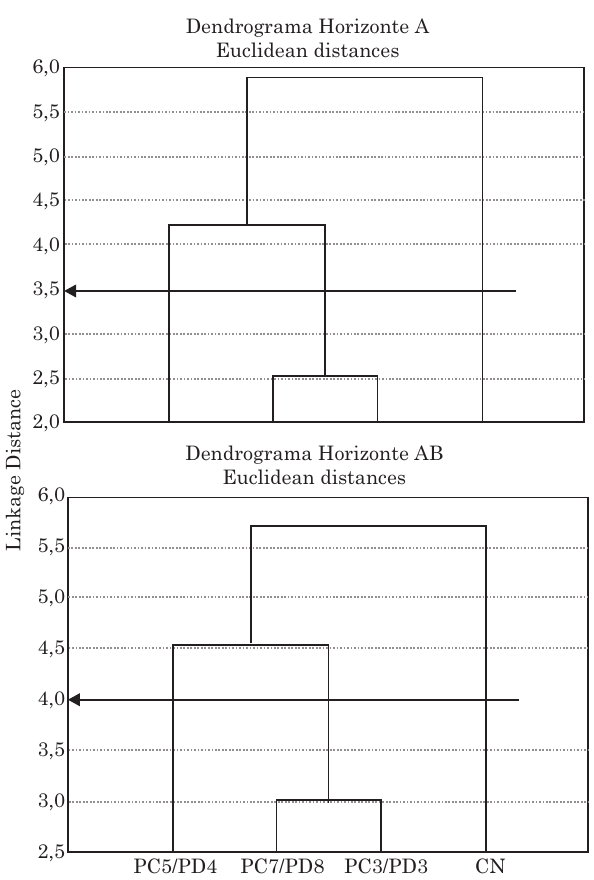
Figura 1. Dendrograma da análise de cluster dos horizontes A e